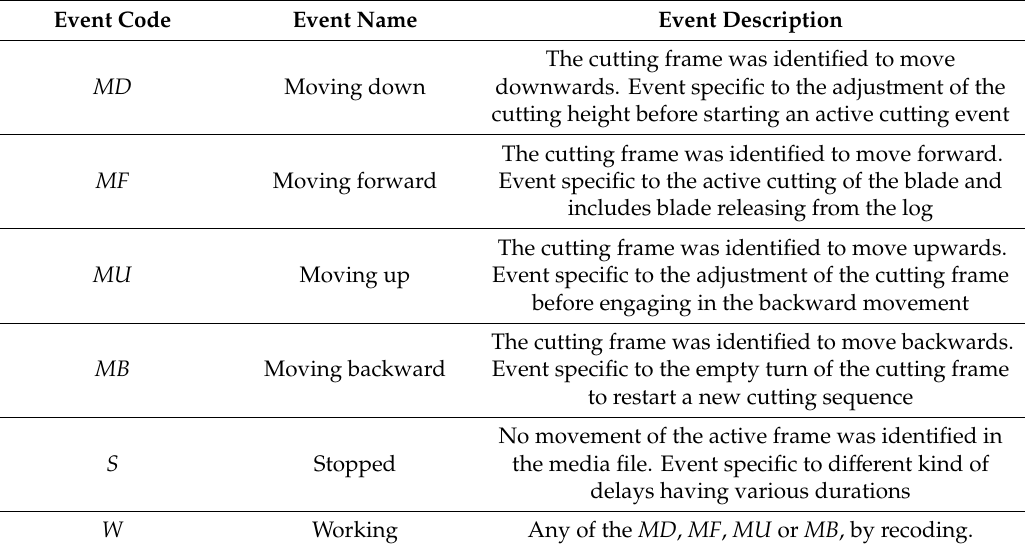
Table 2. Codes used to document the